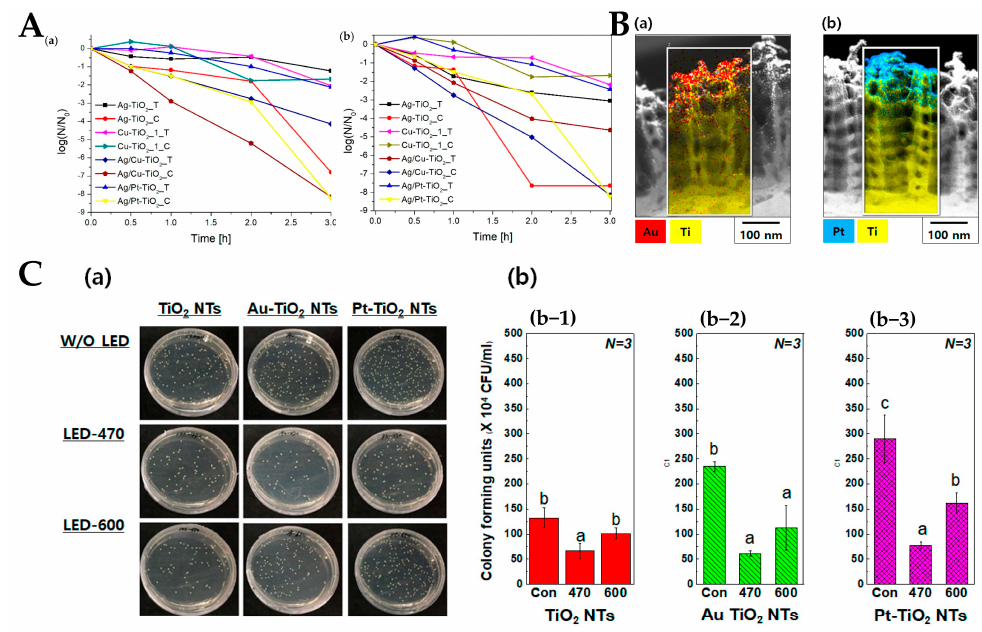
Figure 5. ( A ) antimicrobial activity in the dark ( a ) and under visible light ( b ) ( λ > 450 nm) [58]; ( B ) TEM images of Au–TiO 2 NTs ( a ) and Pt–TiO 2 NTs ( b ); ( C ) photographs of antibacterial S. aureus agar diffusion tests ( a ) and the results of CFUs per unit volume of S. aureus cultured on different letters with or without 470 nm and 600 nm visible irradiation ( b ) [59].